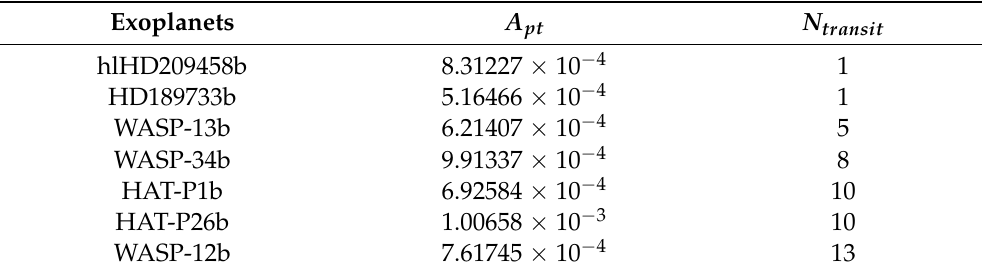
Table 3. Atmospheric contribution and number of transits for representative exoplanets under condition of D tel = 2 m, τ =